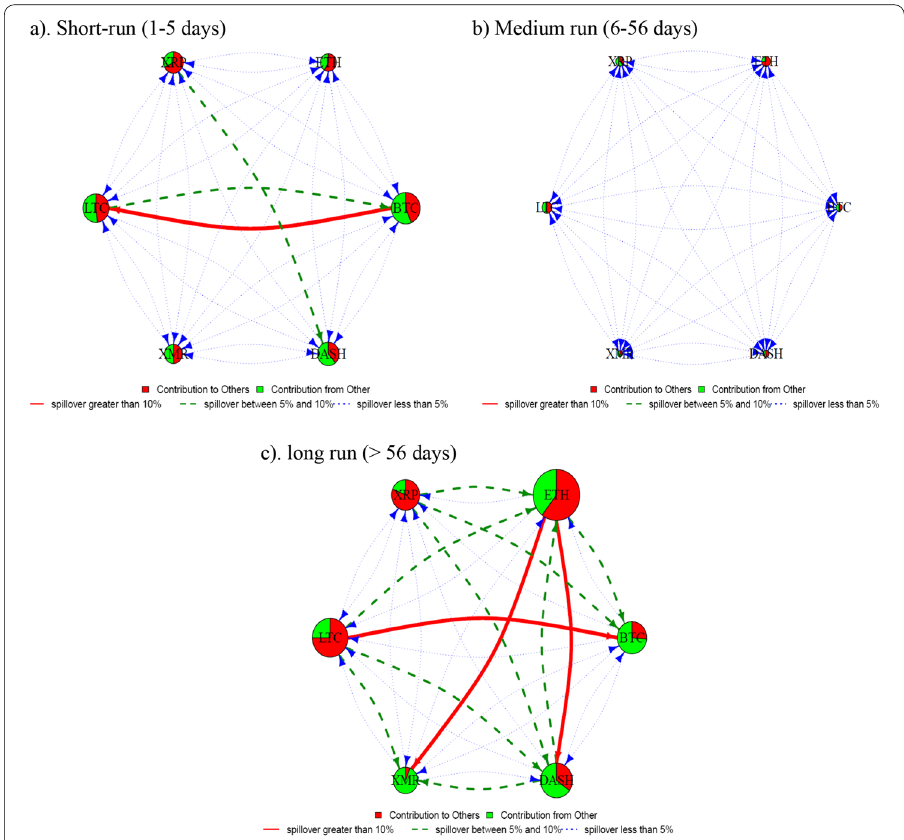
Fig. 3 Frequency domain spillover using BK